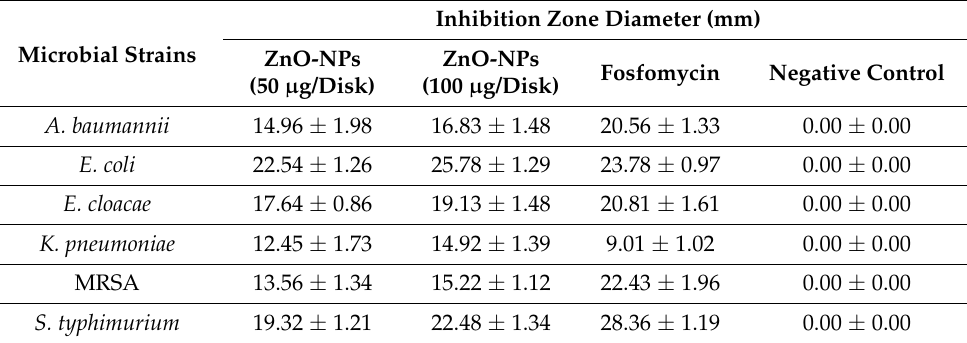
Table 2. Antibacterial efficiency of green ZnO-NPs against bacterial pathogens. Microbial Strains